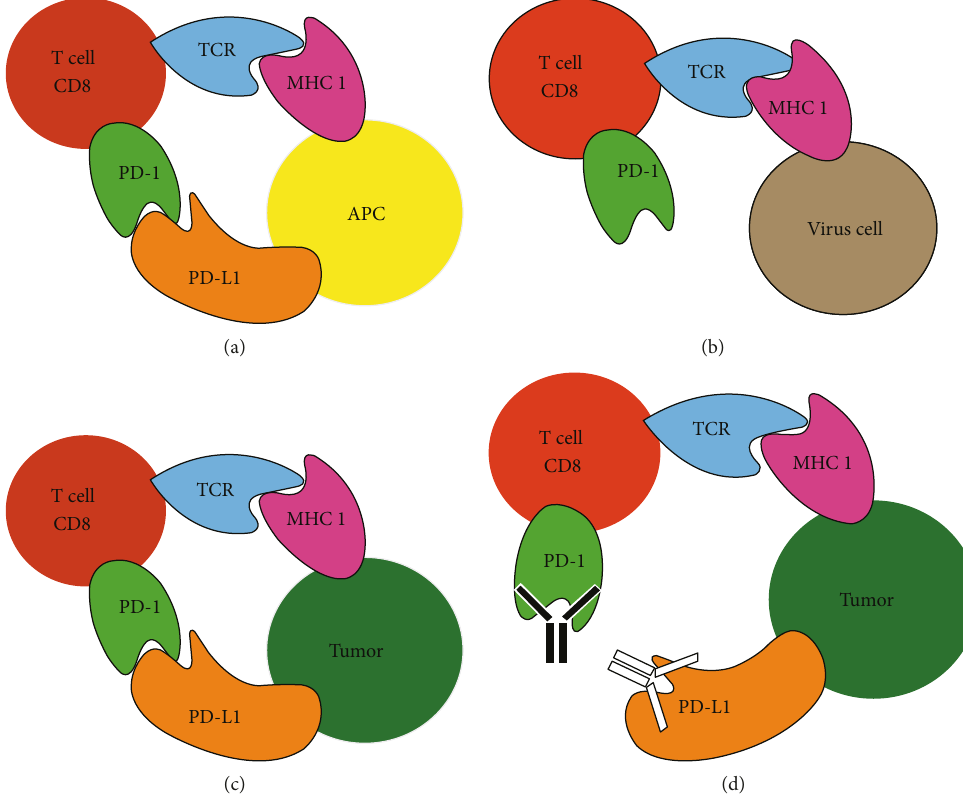
Figure 1: PD-1/PD-L1 ’ s function in normal and tumor environments. (a) PD-1 on T cells binds to a PD-L1 ligand on APC, deactivating the T cell. (b) PD-1 is upregulated in exhausted T cells. (c) Tumor cells express PD-L1, as a survival tactic, which engages with PD-1 expressed by tumor antigen-speci fi c T cells, and deactivate the T cell. (d) Checkpoint inhibitors targeting PD-1 and PD-L1 prevent the tumor cell from binding to PD-1 and thus allow T cells to remain